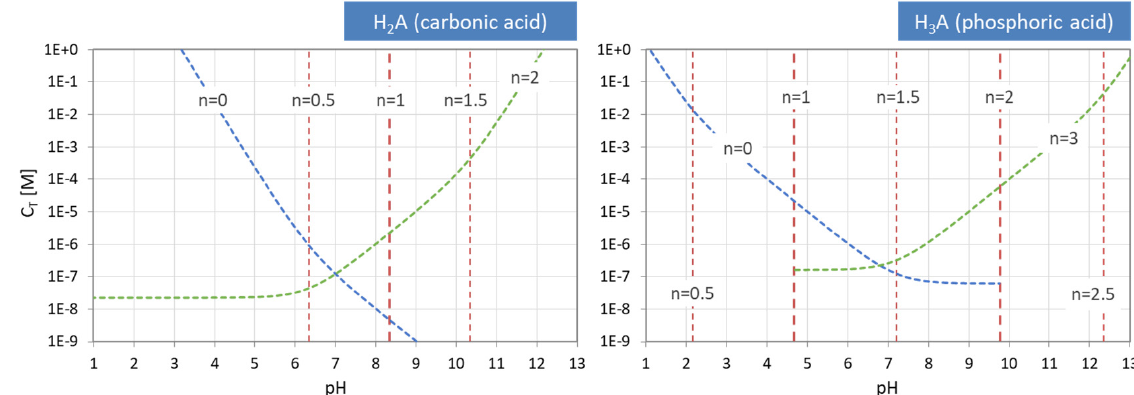
Figure 14. pH–C T diagrams for a diprotic and triprotic acid—the common approach.